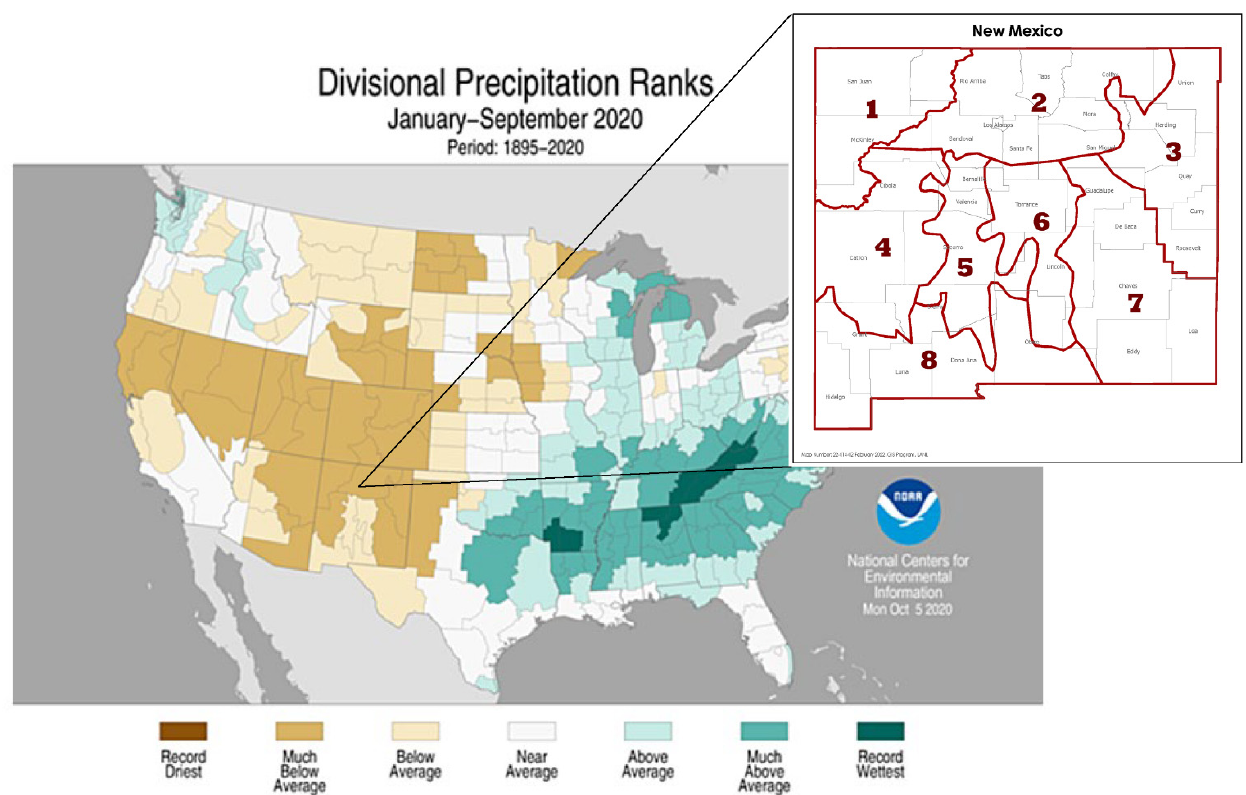
Figure 1. Precipitation ranks from January through September 2020 for the United States climate divisions [35], with an inset map showing the New Mexico climate divisions.